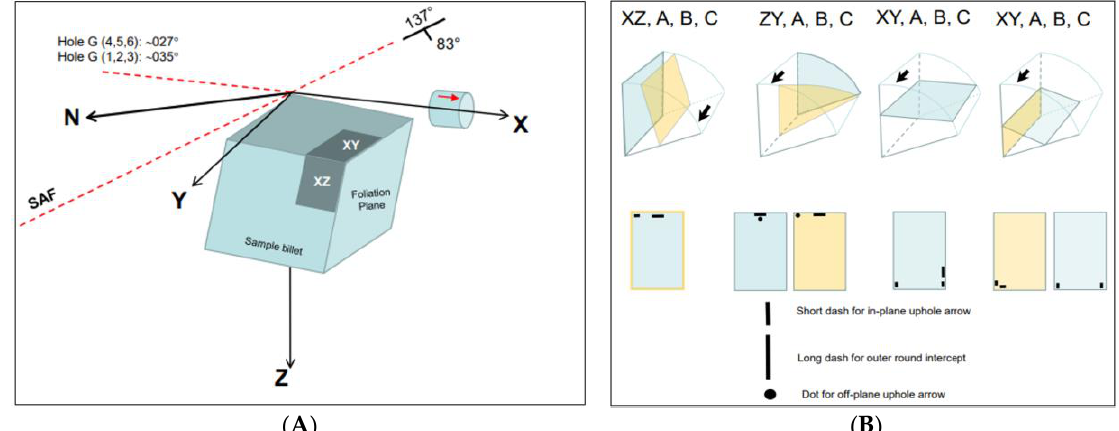
Figure 10. Schematic representation of thin section orientation framework depicting: ( A ) Definition of billet sectioning planes XY, XZ, and YZ with respect to within-billet foliation plane; and ( B ) Suggested markings to be placed on physical thin sections for spatial referencing within the local coordinates of billet models (2D section markings in B were adapted after Tickoff et al. [4]).